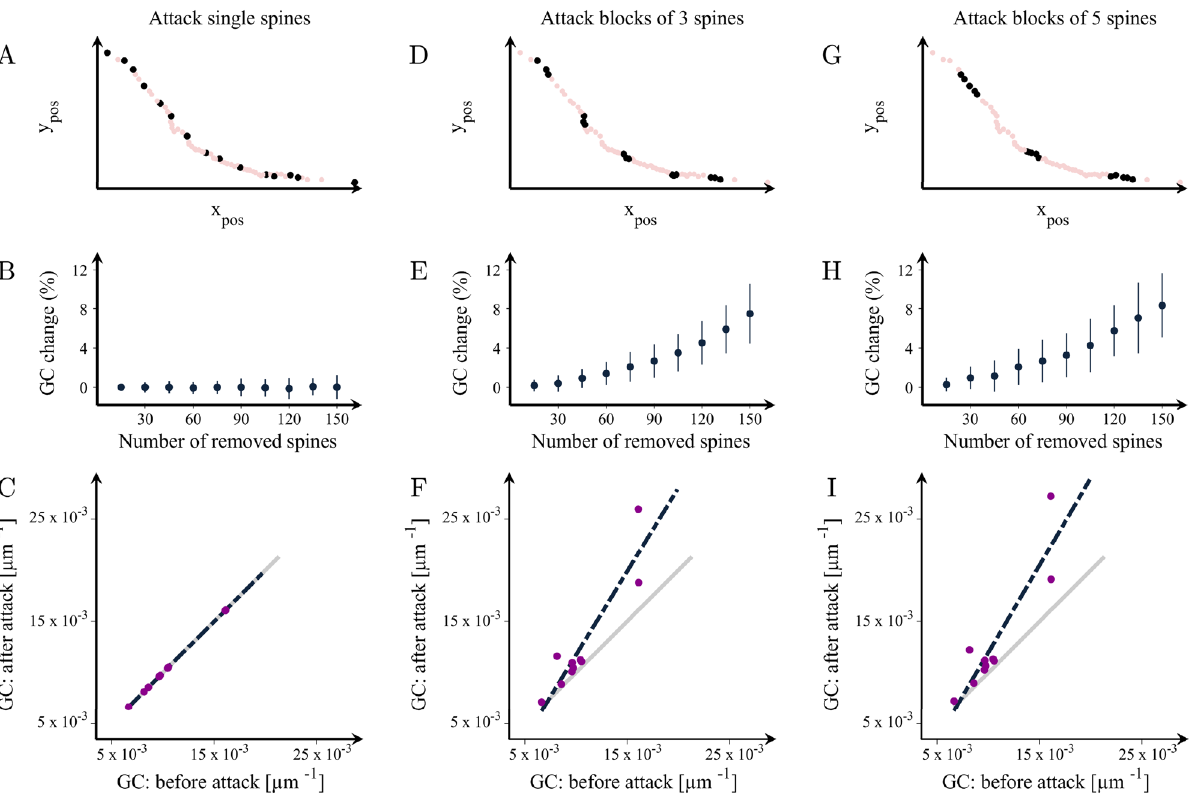
Figure 6. Changes in the mean grouping coefficient after random attacks of spines in healthy dendrites. Illustration of attacks on random spines in a representative dendrite in groups of ( A ) 1, ( D ) 3 and ( G ) 5. ( B,E,H ) Percentage increases in the mean grouping coefficient (GC) in that dendrite as a function of the number of removed spines in the three cases respectively. Mean grouping coefficient of the attacked vs. healthy dendrites after the removal of 150 spines in groups of ( C ) 1, ( F ) 3 and ( I ) 5. The grey line shows the theoretical line of no change in the grouping coefficient, while the black line is the line that best fits the observed data after the